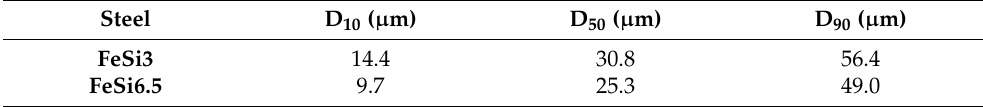
Table 2. Particle size distribution measured by the laser diffraction method. D 10 , D 50 , and D 90 mean the particle size at 10 vol%, 50 vol%, and 90 vol%,